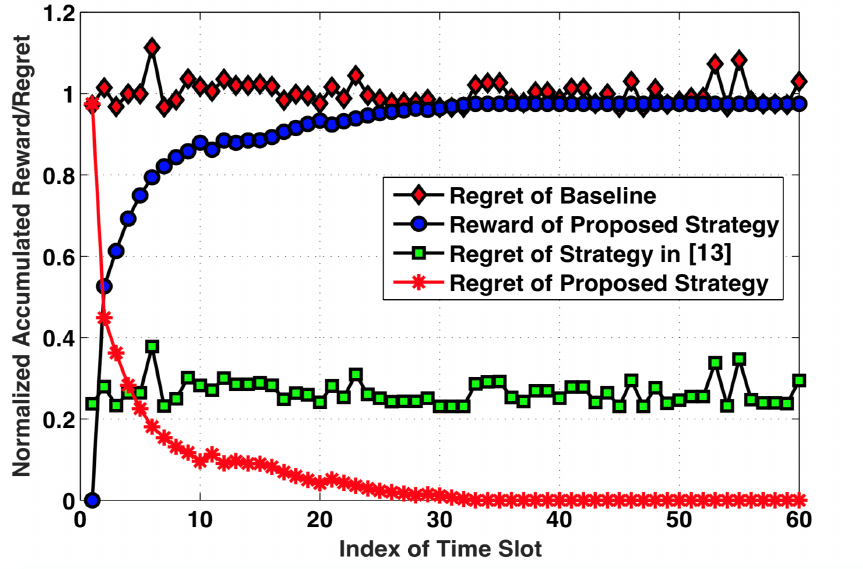
Figure 5. Normalized accumulated reward/regret for different